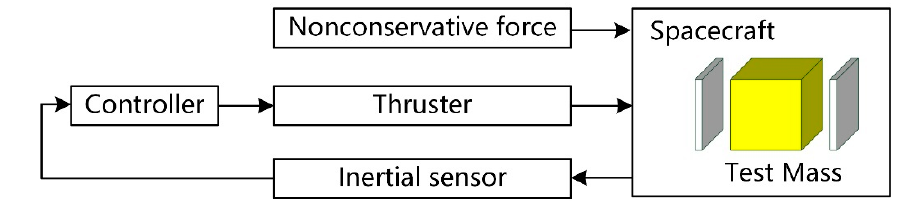
Figure 1. Drag-free control system.